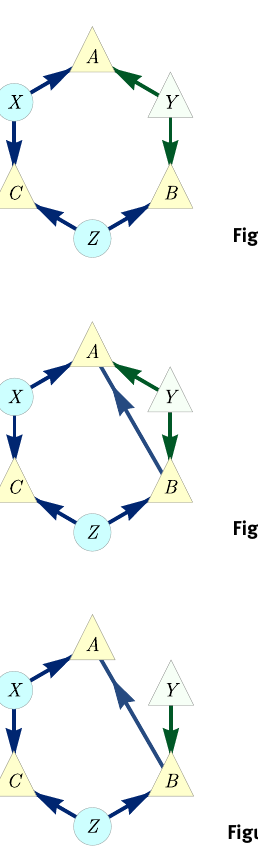
Figure 17: Causal structure #20 in [22]. The d -separation relations are C ⊥ d Y and A ⊥ d Y | B